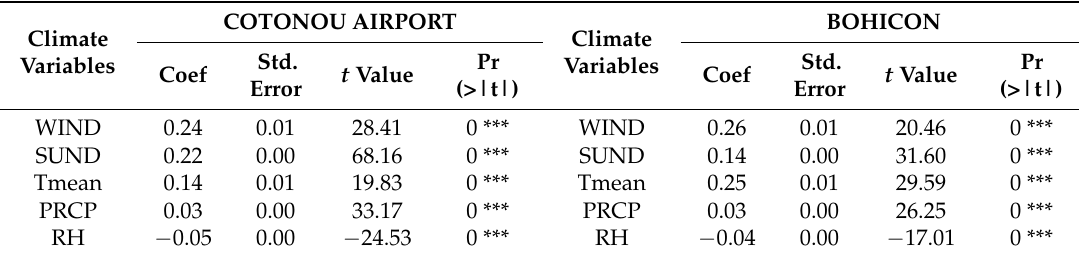
Table 14. Stepwise regression coefficient of pan evaporation and relative humidity (RH), mean temperature (Tmean), wind speed at 10 m altitude (WIND), precipitation (PRCP), and sunshine duration